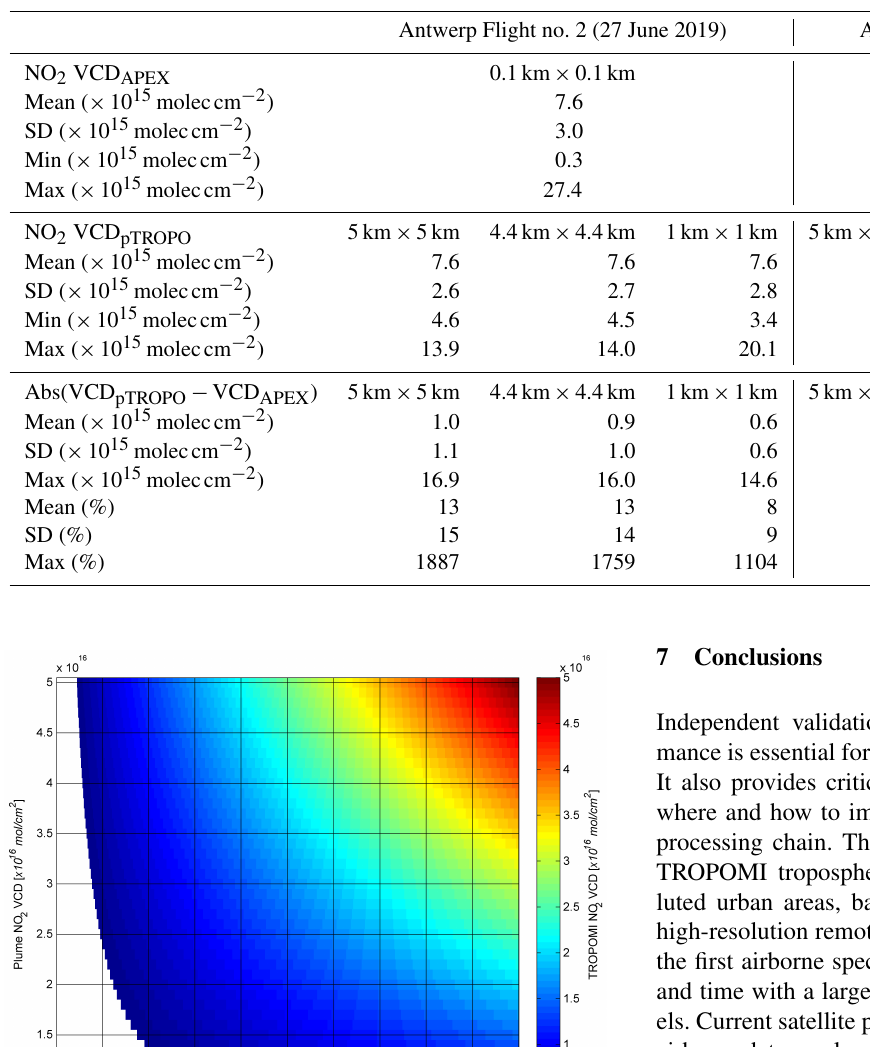
Table 6. NO 2 VCD statistics for (1) two different APEX data sets acquired over Antwerp on 27 and 29 June 2019, (2) pseudo-TROPOMI grids (5km × 5km, 4.4km × 4.4km, and 1km × 1km) constructed by aggregating the native APEX NO 2 VCDs from both former data sets, and (3) absolute and relative differences between the constructed pseudo-TROPOMI NO 2 VCDs and original APEX VCDs.